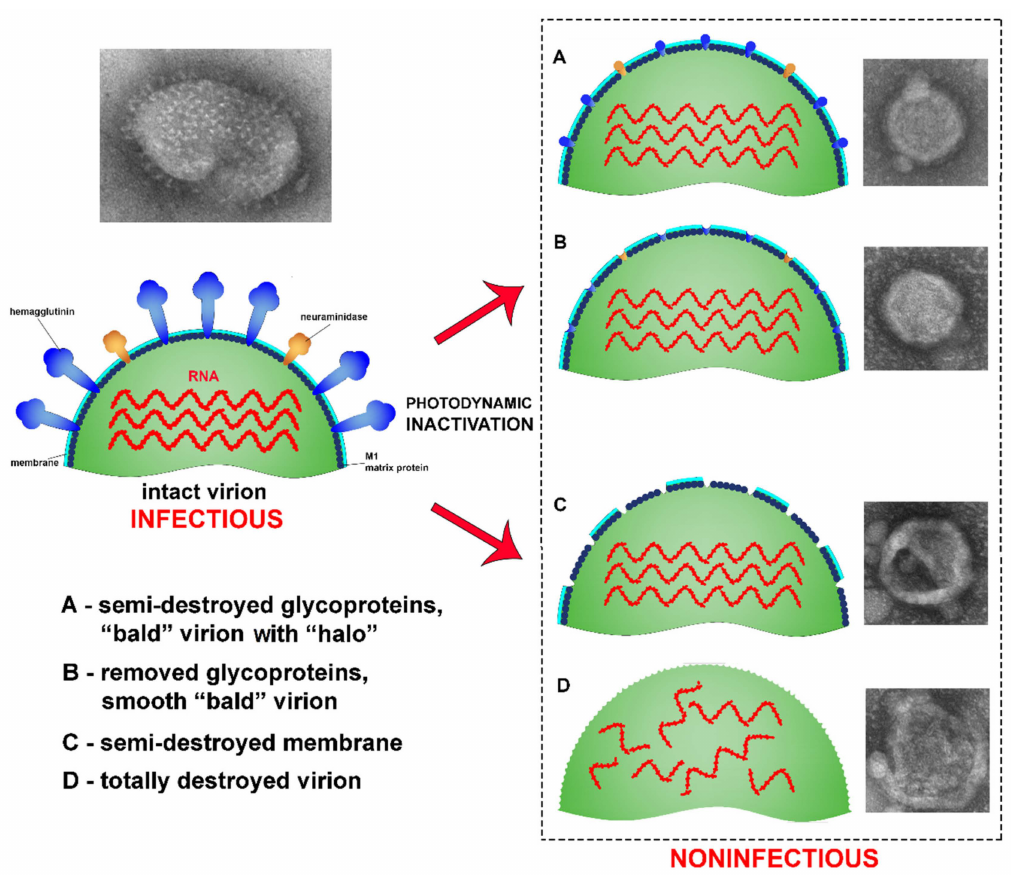
Figure 8. An illustration of the effects photodynamic inactivation has on influenza virus. ( A ) semi-destroyed glycoproteins;( B ) removed glycoproteins; ( C ) Partial membrane destruction; ( D ) Total virion